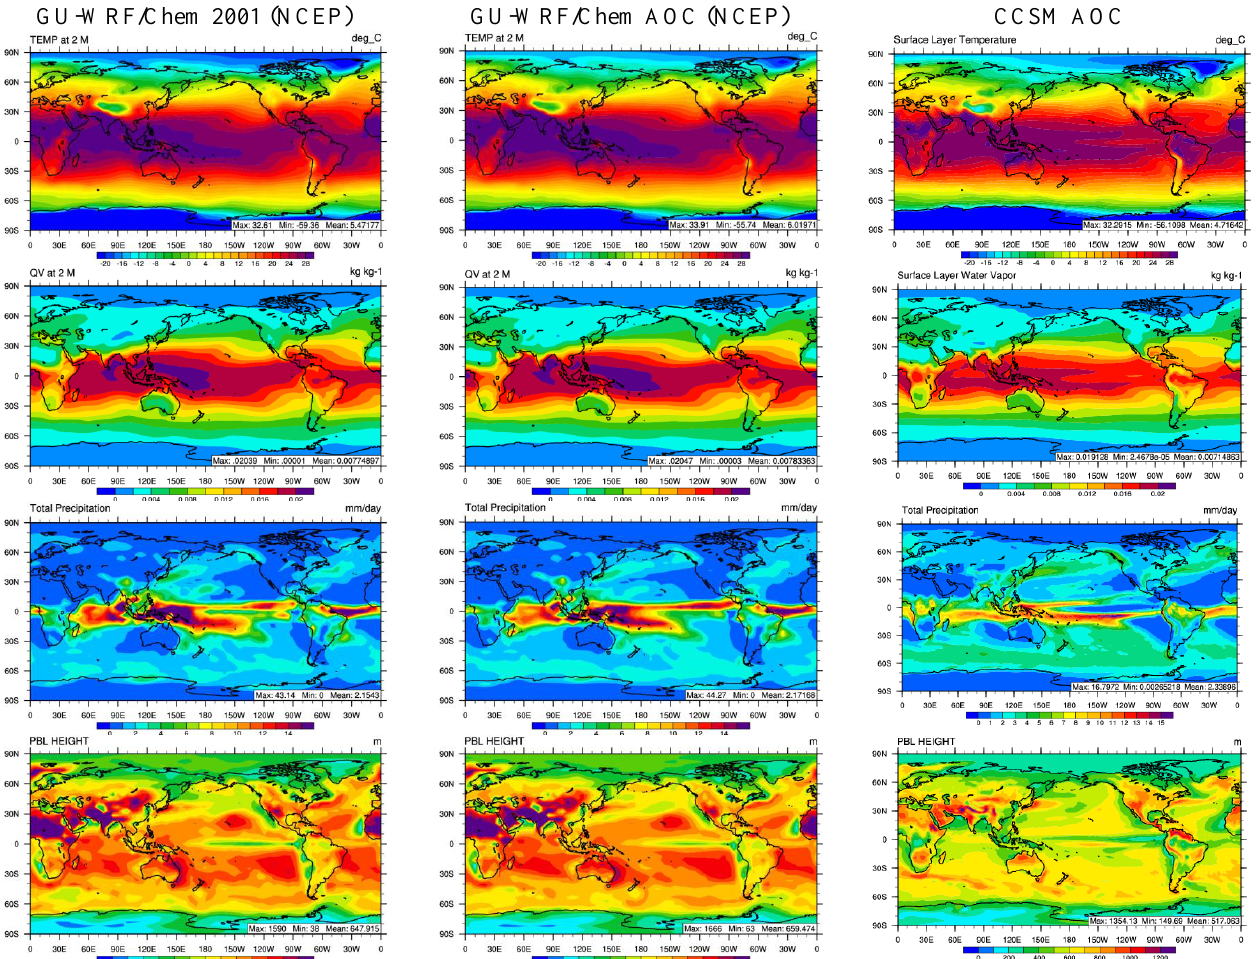
Figure 1. Average spring (MAM) 2-m temperature, 2-m water vapor, precipitation rate, and planetary boundary layer height fields from GU-WRF/Chem simulations of the year 2001 (left), averaged current period consisting of 2001 and 2010 (AOC) (center), and the average of the current period 2000-2014 from CCSM3 (right). GU-WRF simulations are initialized with the NCEP-FNL data. 2050 are shown in Fig. 2 in contrast to the AOF from GU- WRF/Chem and CCSM3 initial conditions